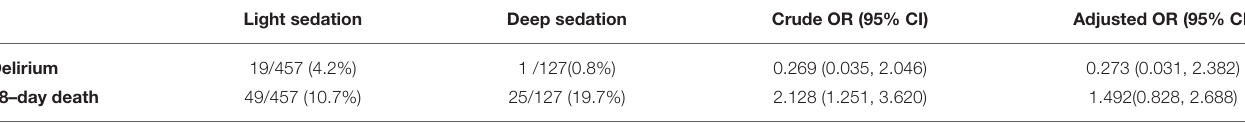
TABLE 2 | Risk potential of deep sedation for outcomes in MV patients( n = 584).